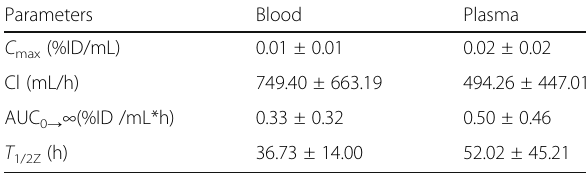
Table 2 Pharmacokinetic parameters for nano-carrier 188 Re-liposome uptake after intravenous injection for patients ( n =12) with tumors Parameters